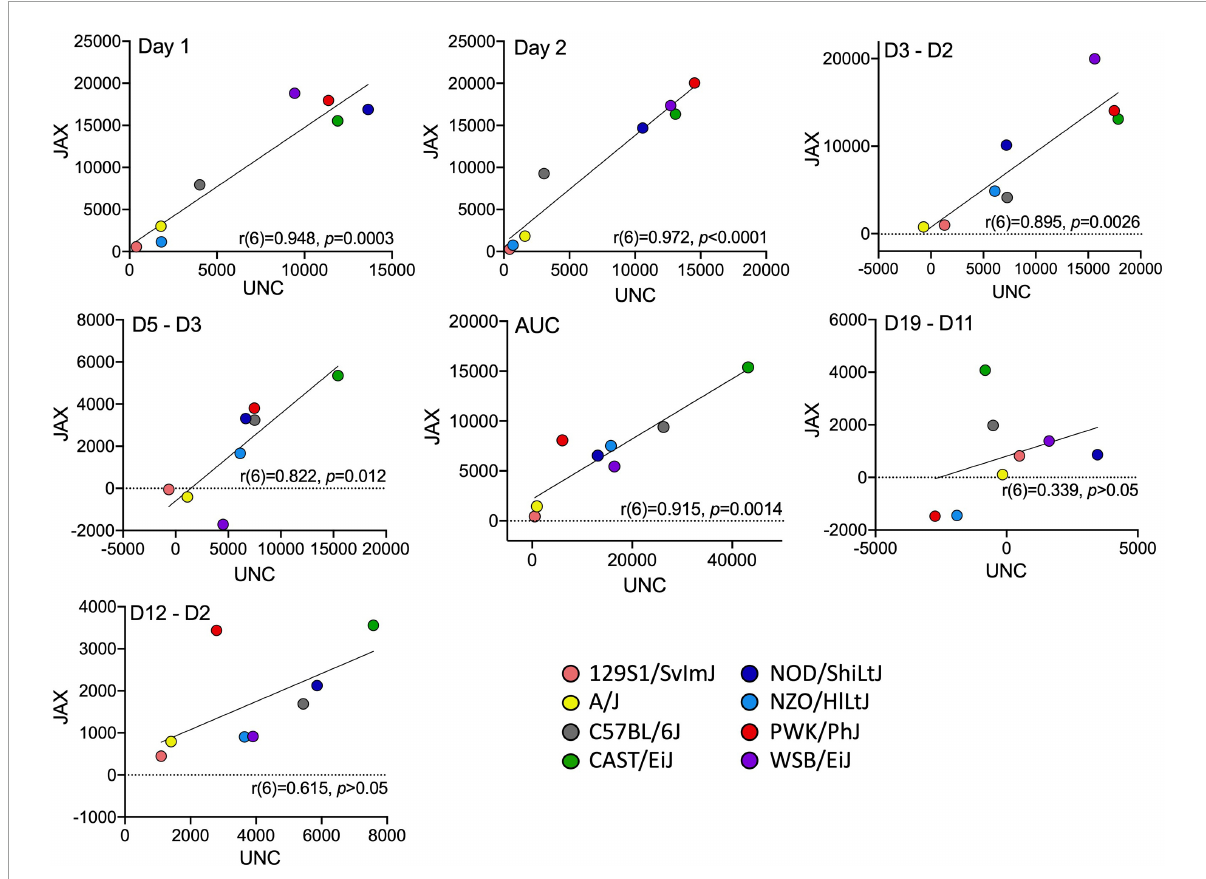
FIGURE4 Correlation of founder strain means for all derived variables for mice tested at UNC and JAX. Each data point represents a strain mean. The line of best fit and correlation coefficient (r) with p -value are shown for each derived variable.